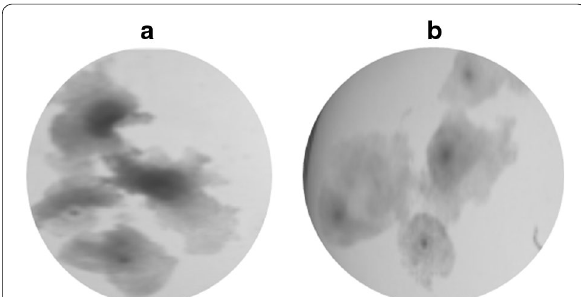
Fig. 4 Toxicity studies of CANCs on oocyte maturation under stereo zoom microscope in 10